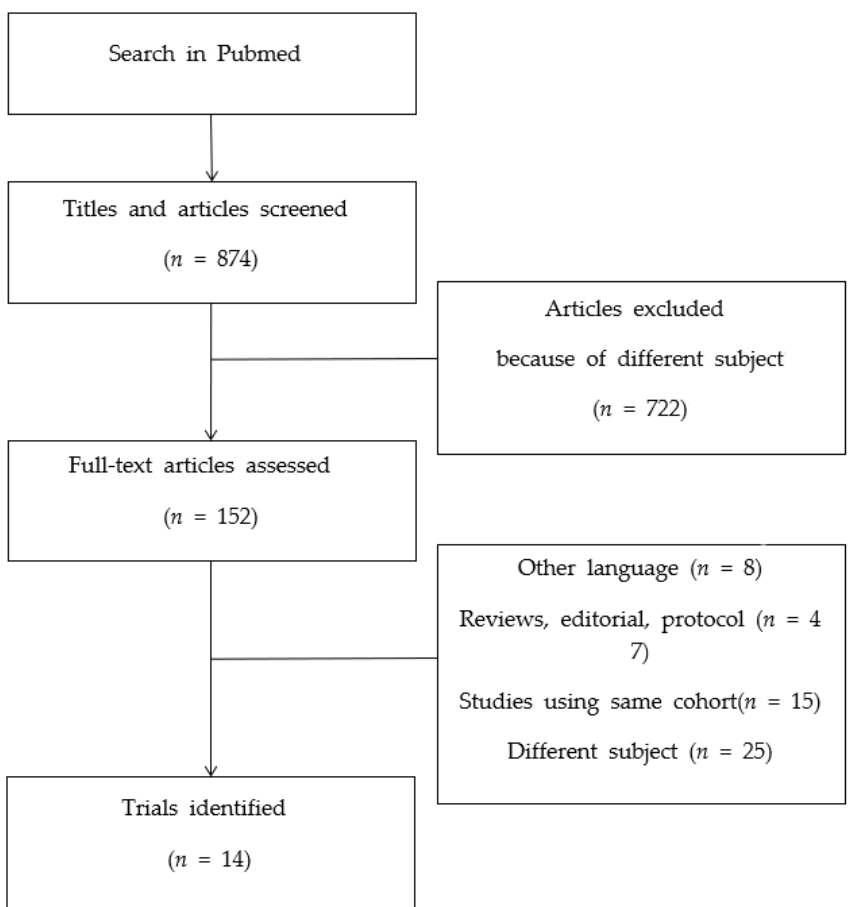
Figure 1. Flow diagram of the literature search of deintensification trials.